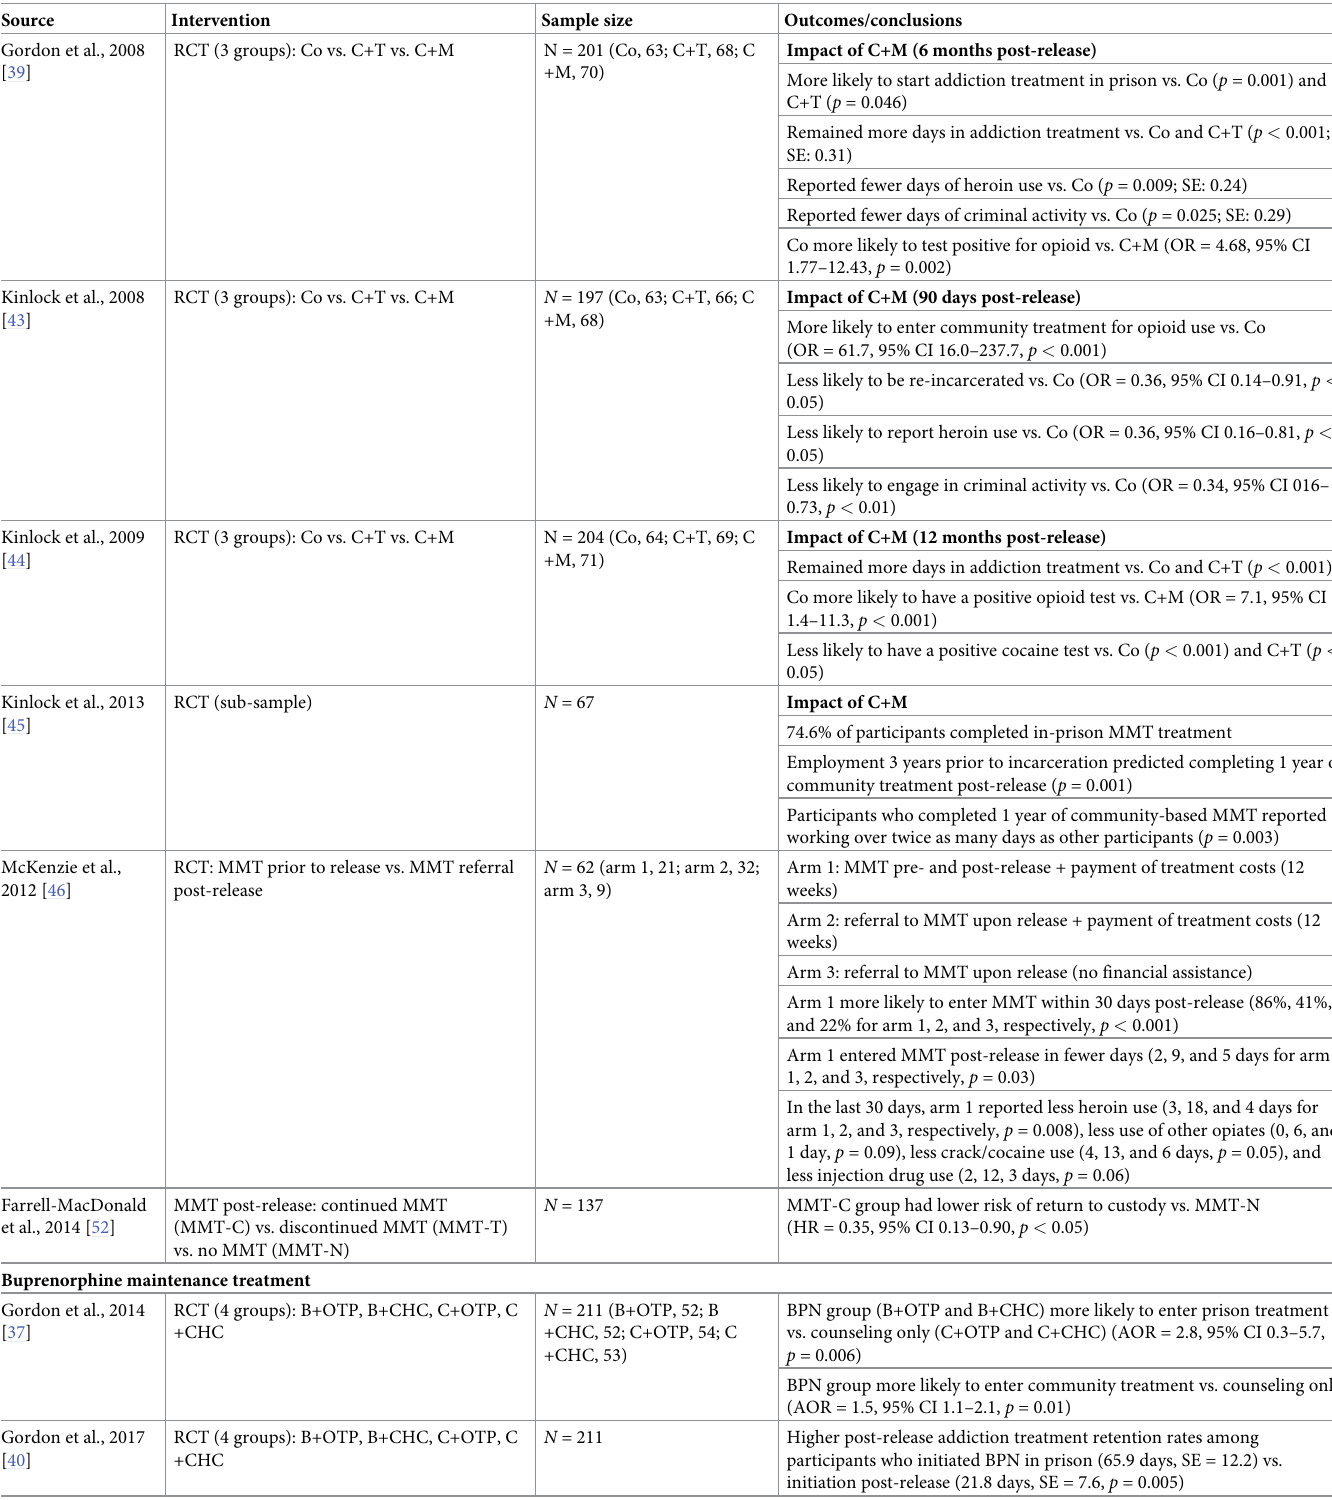
Arm 2: referral to MMT upon release + payment of treatment costs (12 weeks) Arm 3: referral to MMT upon release (no financial